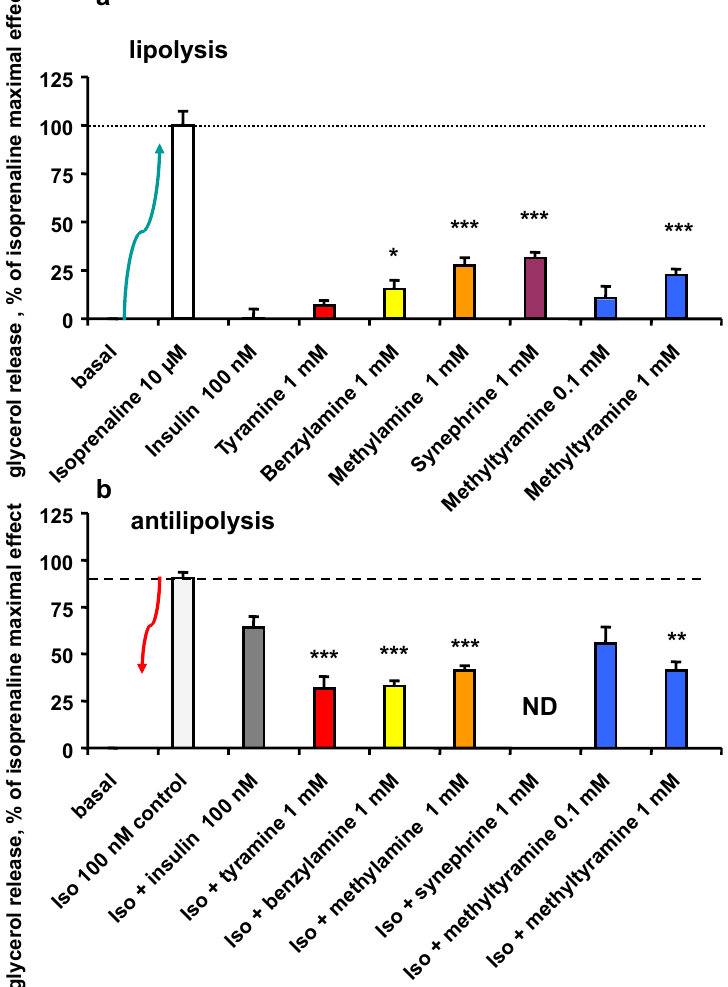
Figure 4. Influence of tyramine, NMT, and reference amines on lipolysis activation or inhibition in human adipose cells. Maximal glycerol release in response to 10 µM isoprenaline was set at 100% (open column), while basal lipolysis was set at 0%. Glycerol release in the presence of the indicated agents was expressed as the percentage of maximal lipolysis. ( a ) Lipolytic activation (green arrow) was partial and significantly lower than the maximal lipolytic effect of isoprenaline (dotted line) with all the tested amines. ( b ) Antilipolytic effect (red arrow) corresponds to the inhibition of glycerol release provoked by 100 nM isoprenaline (open column and dashed line). All tested amines significantly inhibited the isoprenaline-activated glycerol release: tyramine (red column), benzylamine (yellow column), methylamine (orange column) or NMT (methyltyramine, blue columns). Each column is the mean ± SEM of 14 – 16 determinations. For ( a , b ), significantly different from the effect of insulin (grey column) at: * p < 0.05; ** p < 0.01; *** p < 0.001. Iso: isoprenaline 100 nM. ND: not determined.